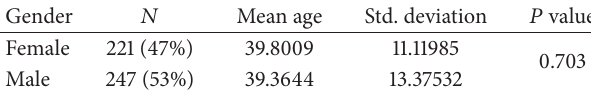
Table 5: Patients with single infection (age and gender).